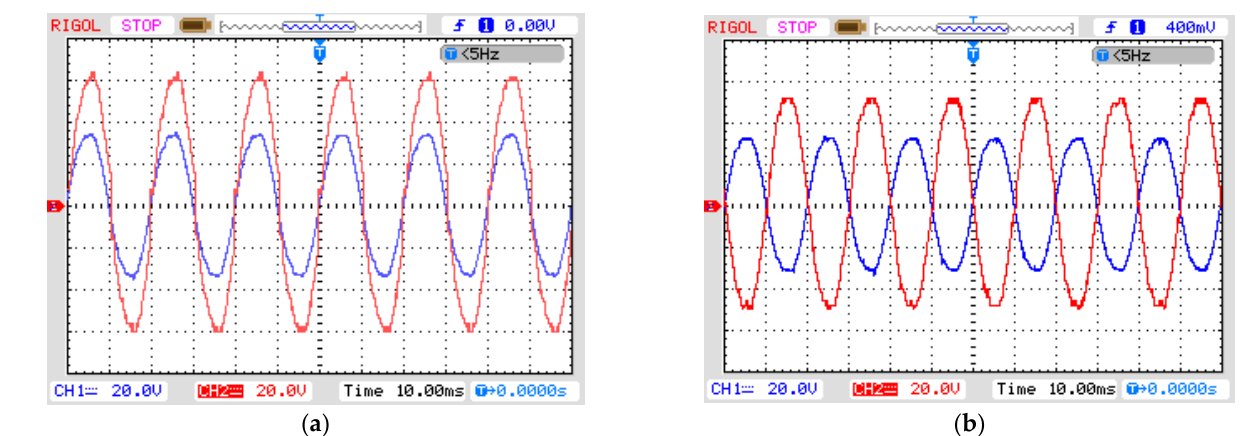
form and ( b ) inverted form.